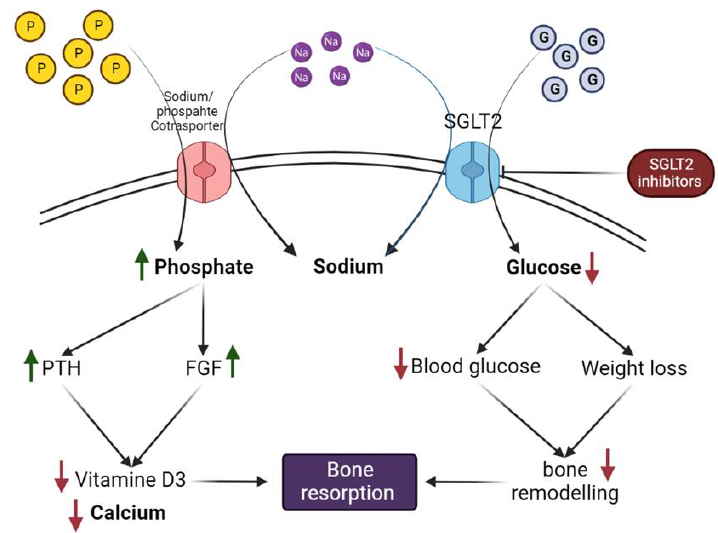
Figure 5. Mechanism of SGLT2 inhibitors on bone metabolism. The sodium–phosphate cotransporter in the proximal tubules of the kidney can carry sodium and glucose cotransporters. Increased phosphate absorption and urine